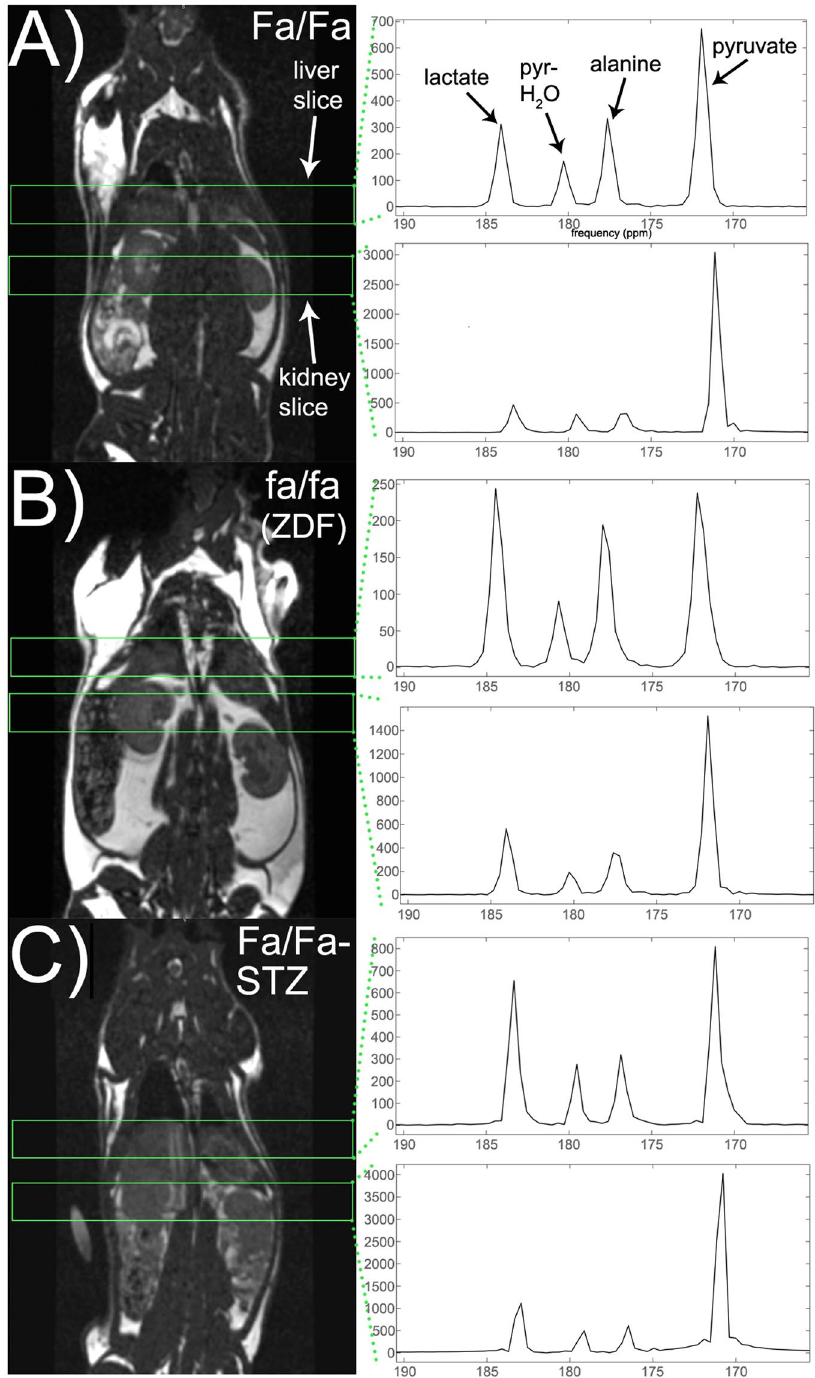
Figure 1. Localized MR spectra of HP [1- 13 C]pyruvate from individual Zucker rats sampled from the subgroups described in text: wild type Zucker ( Fa/Fa ) ( A ), obese Zucker ( fa/fa ) ( B ), and wild type Zucker treated with STZ and subsequent insulin withdrawal for 24–36 h ( Fa/Fa-STZ ) (C). Resonances corresponding to [1- 13 C]lactate (184 ppm), [1- 13 C]pyruvate hydrate (180 ppm), [1- 13 C]alanine (177 ppm), and [1- 13 C]pyruvate (172 ppm) are easily identified in all spectra (arrows). HP 13 C spectra are shown to the right of standard coronal anatomic 1 H MRI images indicating positions of slices for 13 C MR data acquisition (green rectangles). In each rat, spectra were acquired from each of two adjacent 12-mm thick axial slices through the liver and kidneys, respectively. MR spectra were summed over all acquisition time points over the 30-second acquisition window, and scaled to the approximate spectral noise level (i.e. the MR data has units of signal-to-noise